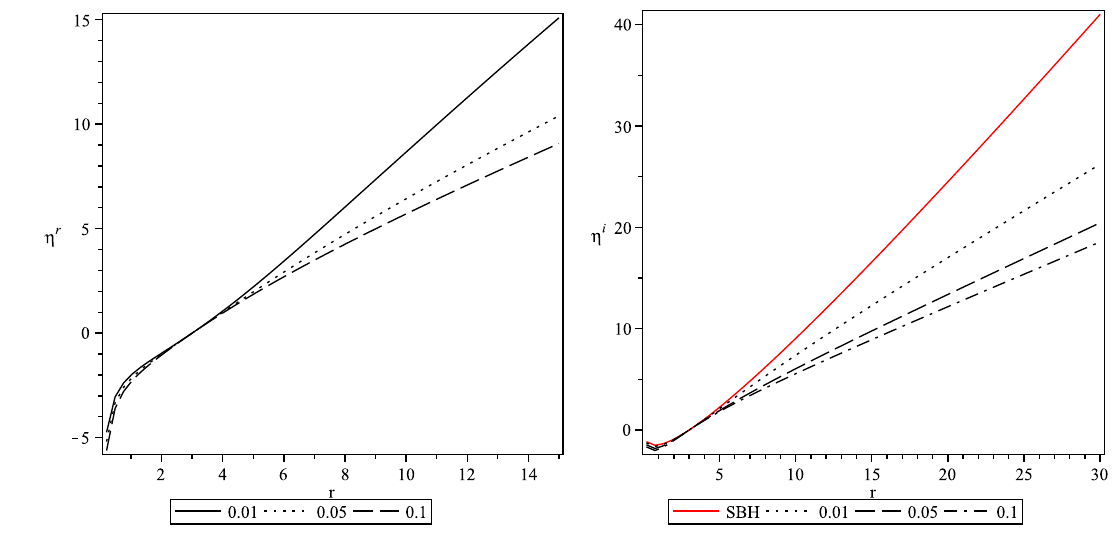
Fig. 7 Variation of geodesic vectors for M = 1, w q = − 0 . 95, a = 0 . 1 and different mentioned values of q ; left figure: radial geodesic vector with ICII, right figure: angular geodesic vector with ICII; solid line curve represents the corresponding variation for SBH